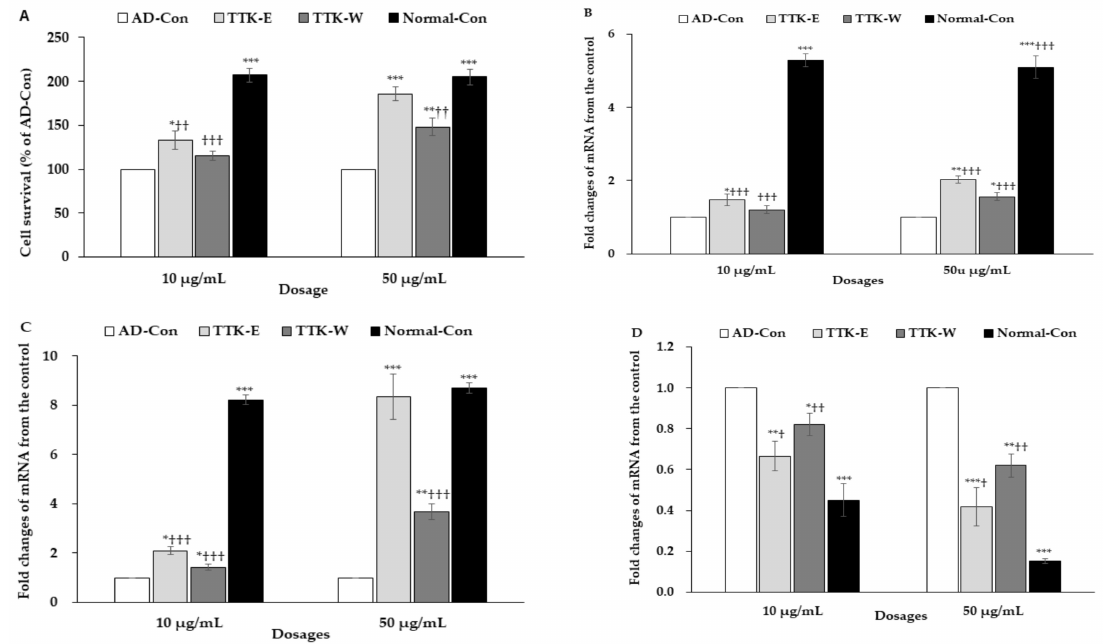
Figure 1. Cell survival and expression of brain growth factors in the nerve growth factor-administered PC12 cells. The cells had treatments with 70% ethanol Tetragonia tetragonioides or its water extract with 10 and 50 µ g / mL dosages, and after 1 h, cell death was induced by 10 µ M amyloid- β (25–35). After 24 h treatment, 3-(4,5-dimethylthiazol-2-yl)-2,5-diphenyltetrazolium bromide (MTT) assay and mRNA expression were measured. Amyloid- β (25–35) was administered without Tetragonia tetragonioides Kuntze (TTK) extract (AD-Con), ethanol extract (TTK-E), or water extract (TTK-W), and 10 µ M amyloid- β (35–25)wasadministeredwithoutTTKextract(Normal-Con). ( A )Cellsurvivaldeterminedby MTT assay. ( B ) Brain-derived neurotrophic factor (BDNF) mRNA expression. ( C ) Ciliary neurotrophic factor (CNTF) mRNA expression. ( D ) Tau mRNA expression. The units for mRNA expression were fold-changes of mRNA expression from the control. Each value represents the mean ± SD ( n = 3). # Significantly di ff erent among the groups in one-way ANOVA at p < 0.05, ## p < 0.01, and ### p < 0.001. * Significantly di ff erent from AD-Con at p < 0.05, ** p < 0.01, and *** p < 0.001 in the Tukey test. † Significantly di ff erent from the Normal-Con at p < 0.05 and †† at p < 0.01 in the Tukey